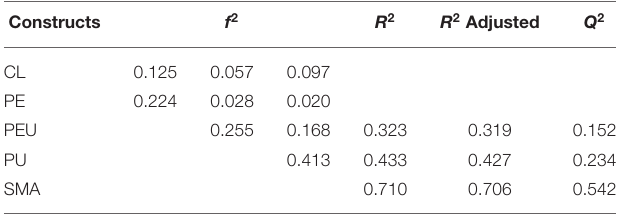
TABLE 4 | Standard assessment criteria of a structure model.